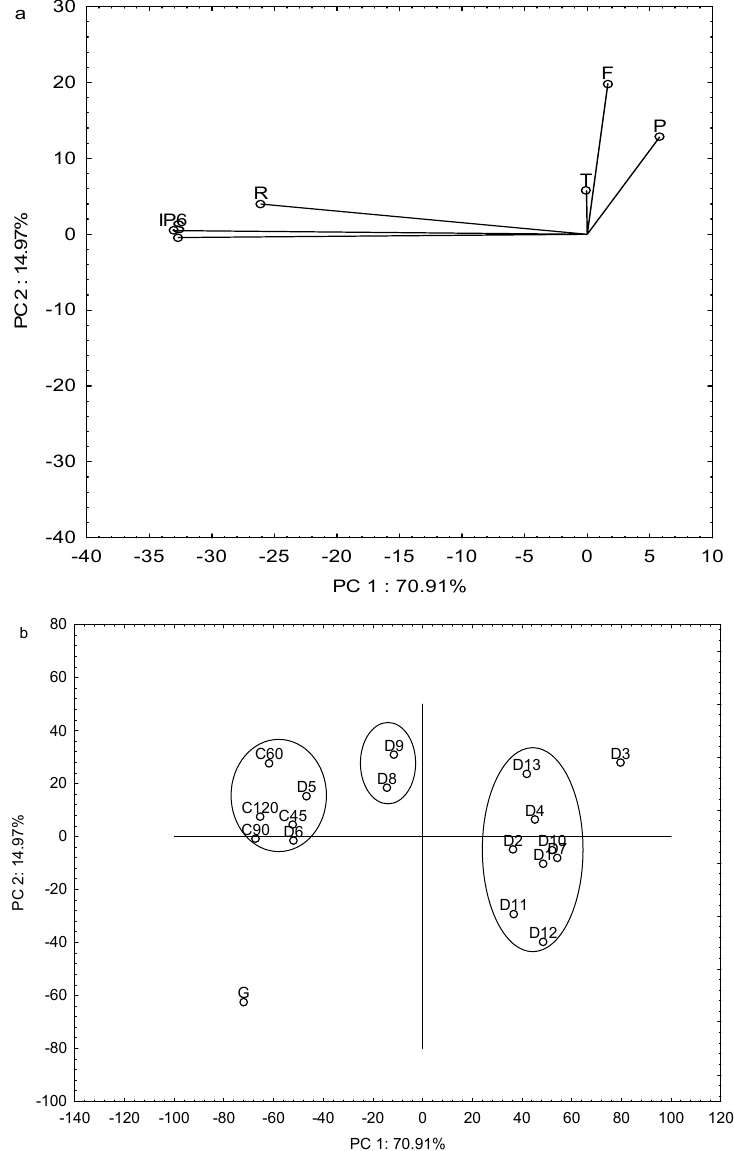
Figure 4. Principal component analysis. ( a ) Projection of the variables on the factor-plane, ( b ) Projection of the cases on the factor-plane. P = Total phenolics, T = condensed tannins, F = flavonoids, R = raffinose, S = stachyose, G = germination, C = cooking, D = DIC treatments.